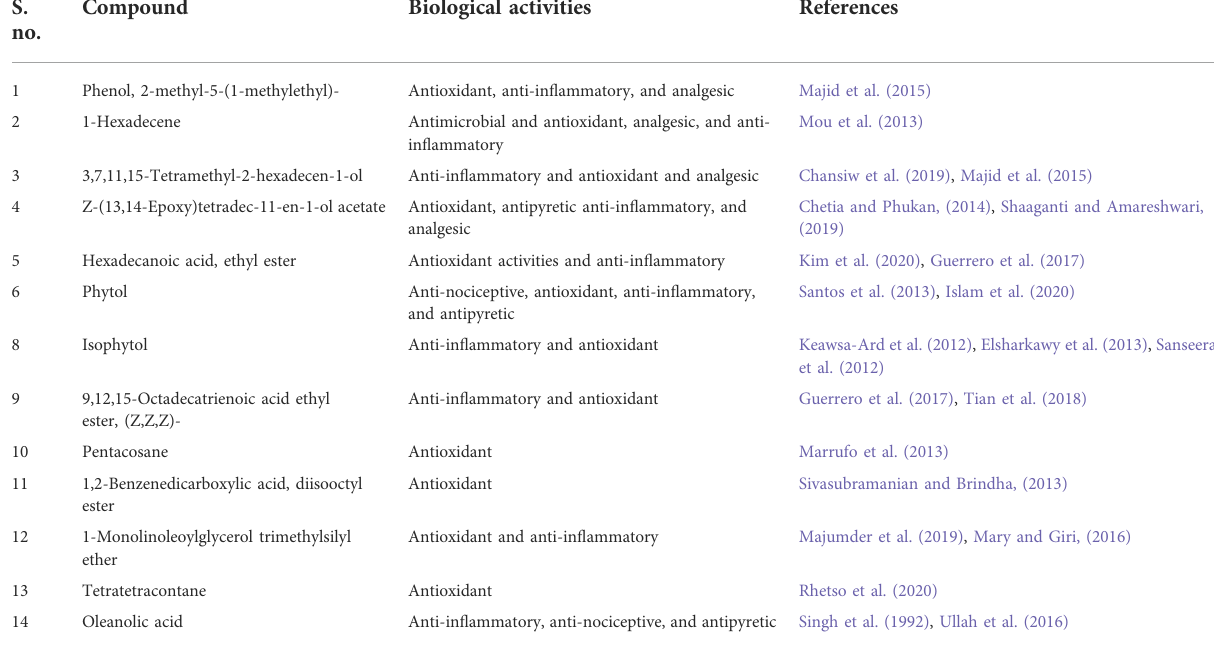
TABLE 4 List of biological activities of compounds of Justicia adhatoda identi fi ed through gas chromatography – mass spectrometry. S.